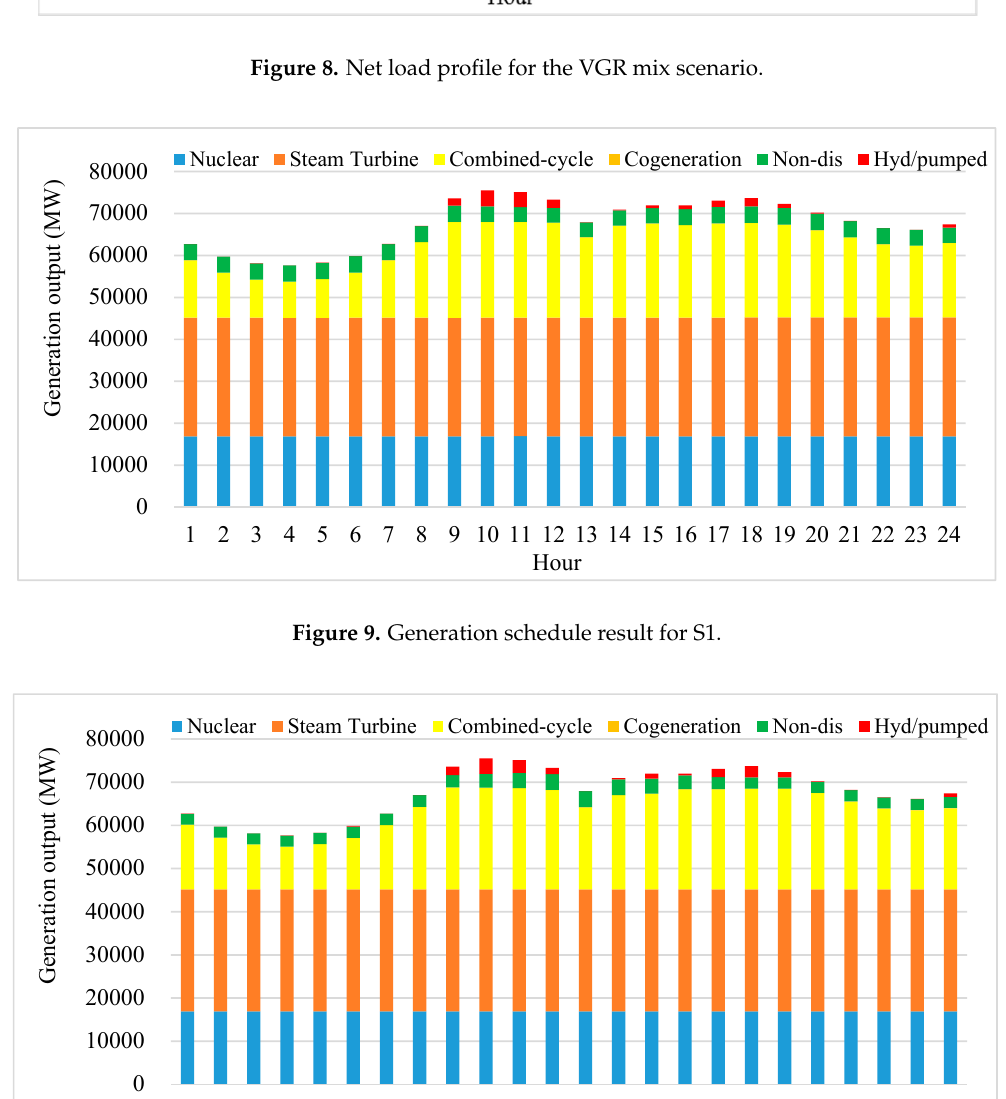
Figure 10. Generation schedule result for S19.